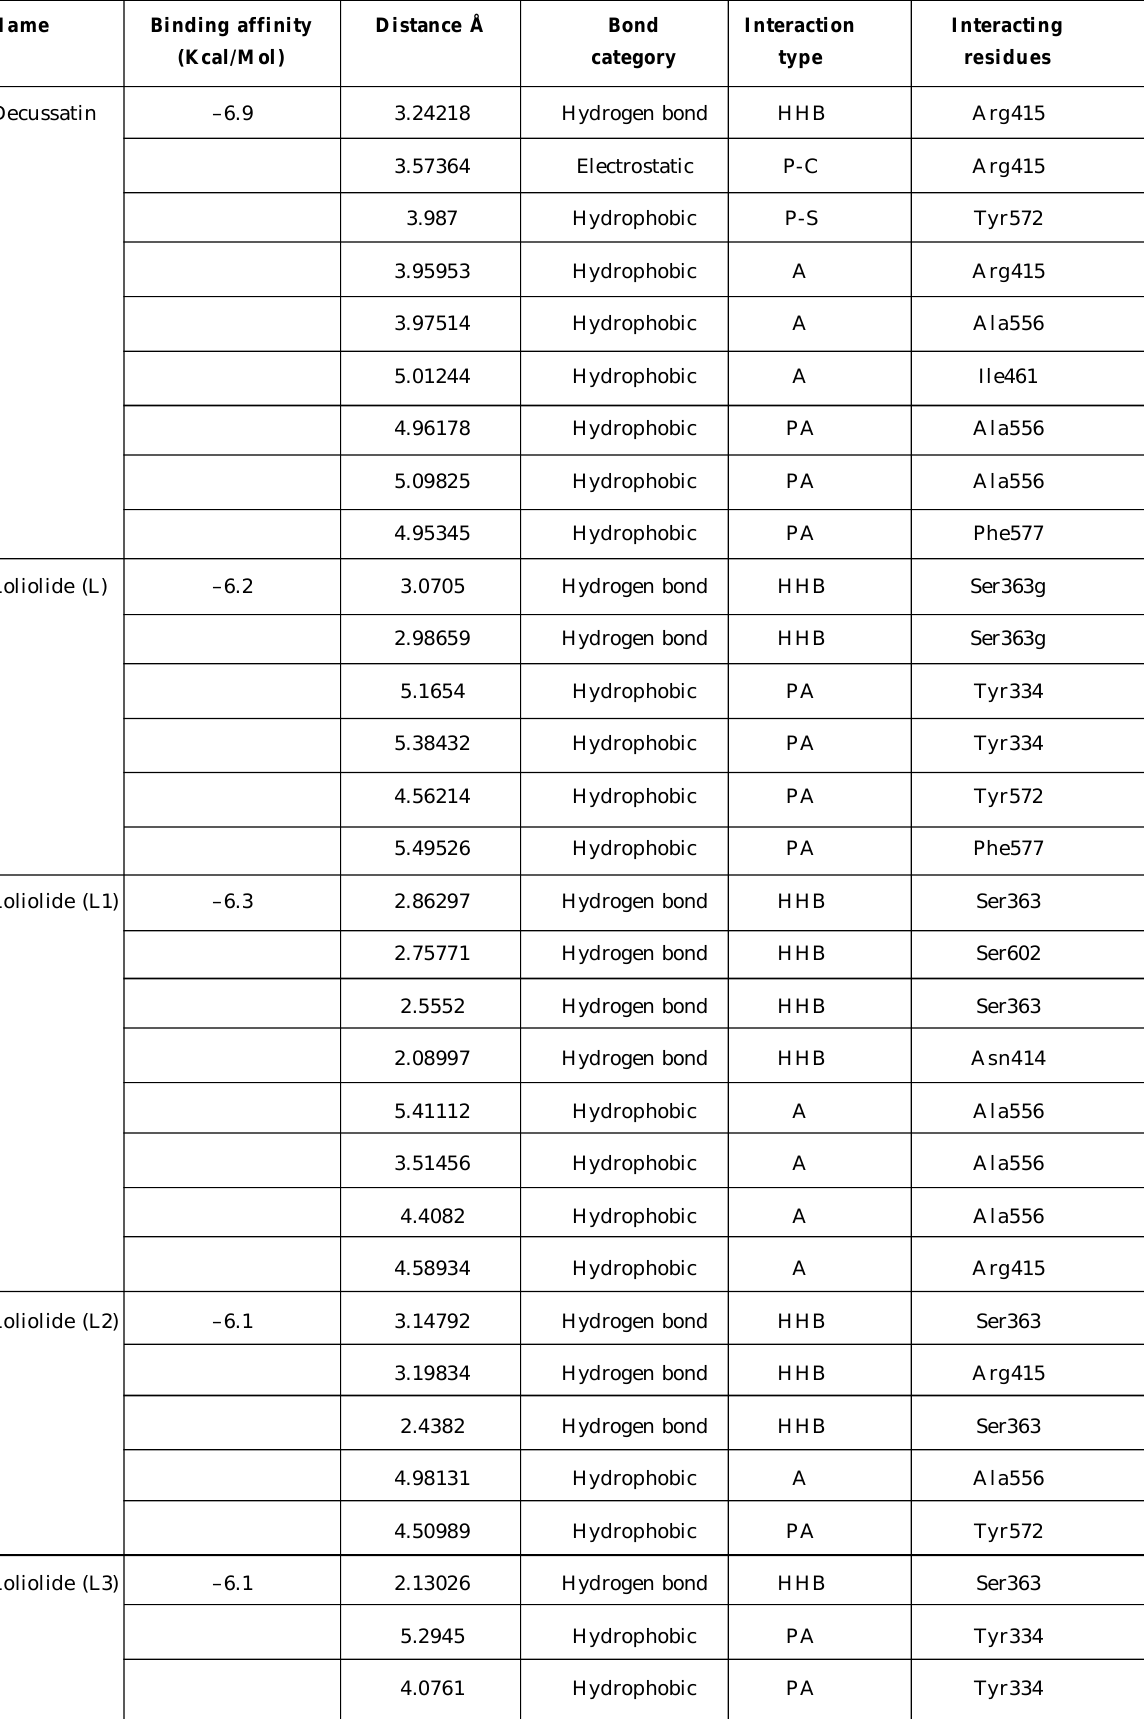
Table 5: Post dock interaction profile obtained from Accelrys Discovery Studio for the Ligands-Kelch domain